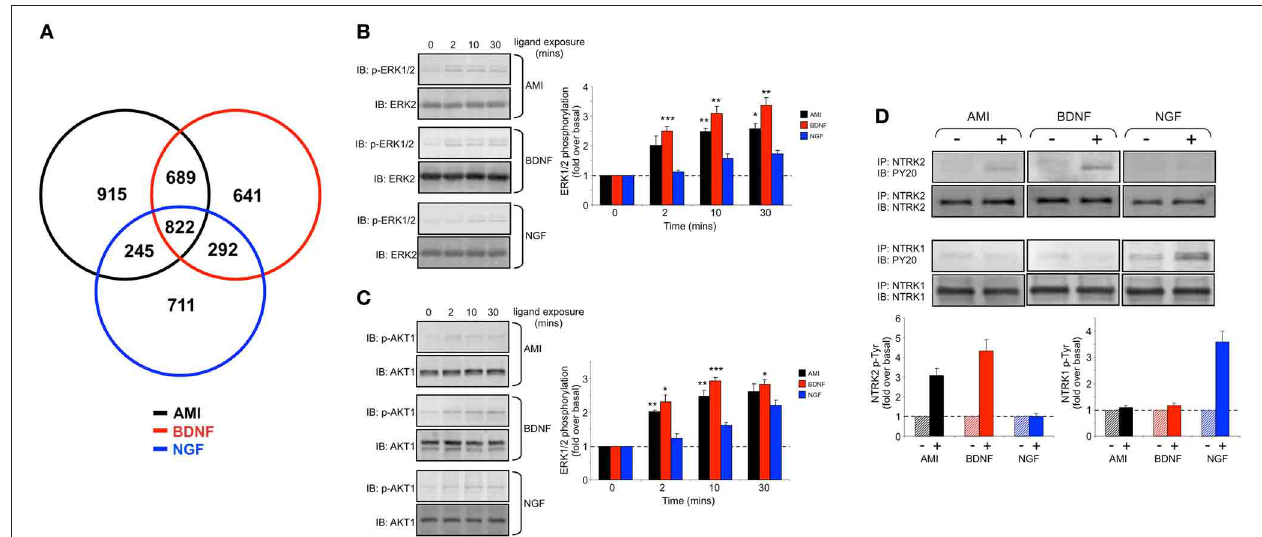
was measured at each time point from three independent experiments. (C) Time course data for AMI-, BDNF- or NGF-mediated v-akt murine thymoma viral oncogene homolog 1 (AKT1) phosphorylation which denotes kinase activation (measured with p-AKT1 phosphospecific antibody). Statistical significance (Student’s t -test) ( ∗ p < 0 . 05, ∗∗ p < 0 . 01, ∗∗∗ p < 0 . 001) for AMI and BDNF compared to NGF was measured at each time point from three independent experiments. (D) Treatment of SH-SY5Y cells (20min) with AMI (10nM) or BDNF (10ng/ml) results in the increase of phosphotyrosine content [measured using anti-phosphotyrosine (p-Tyr) antibody—PY20] of immunoprecipitated (IP) NTRK2, while only NTRK1 is significantly phosphorylated by